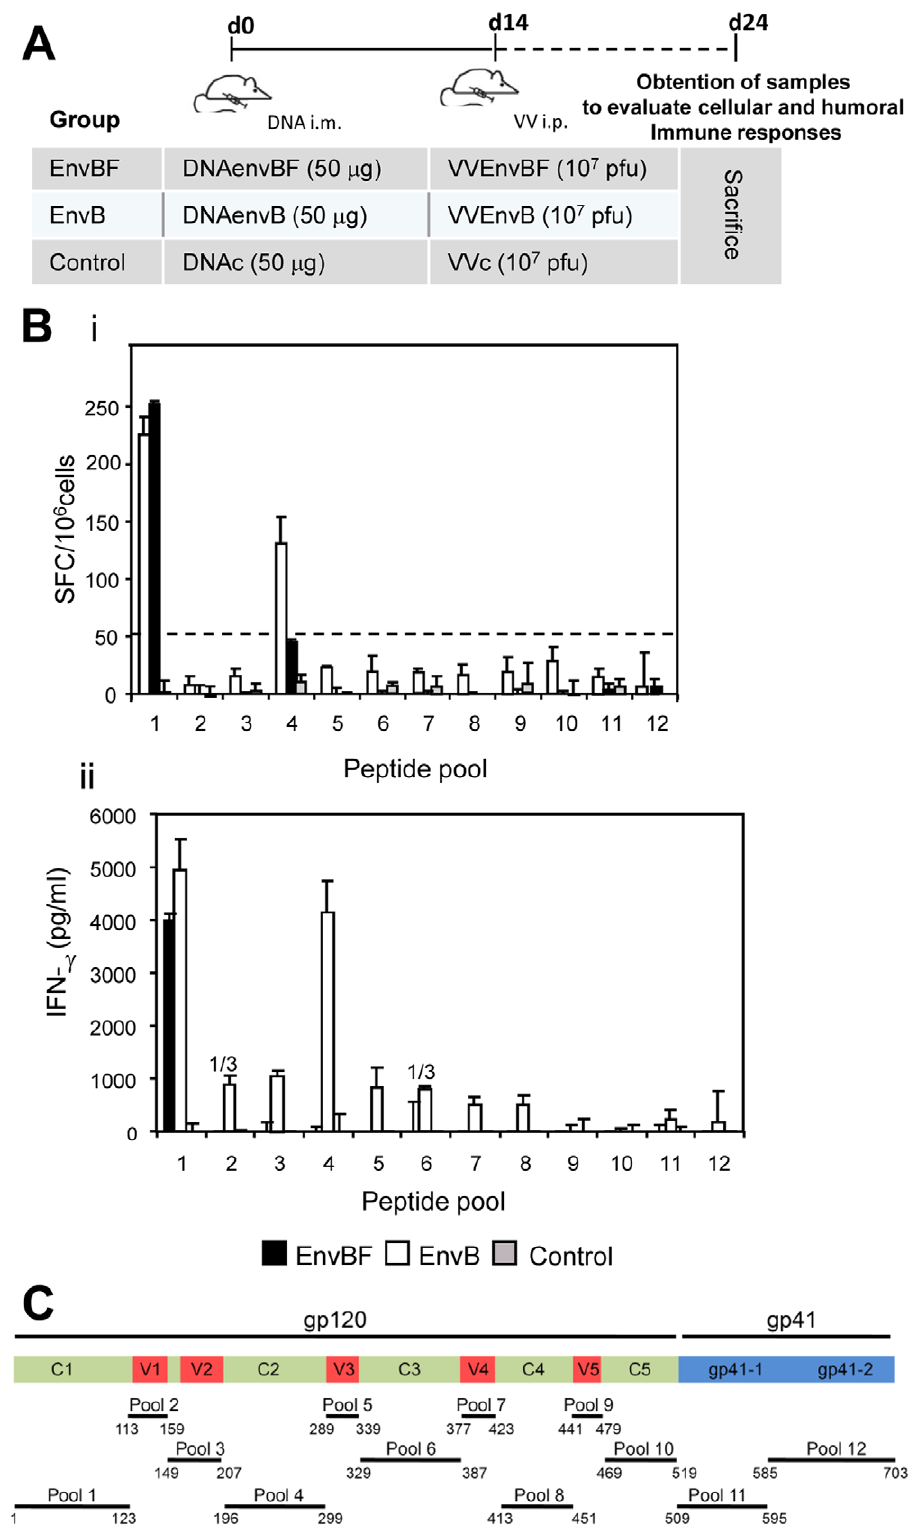
Figure 2. Immunogenicity of EnvBF vs EnvB proteins: cellular responses induced after DNAprime/VVboost vaccine regimes. A ) Description of the immunization scheme applied in groups of four Balb/c mice. B ) Ten days after the last immunization dose, cellular immune responses against EnvB were evaluated by ELISPOT (i) or ELISA (ii). To this, splenocytes from mice of the different groups were restimulated with the Env Con B peptide pools of indicated, during 24 hrs (i) or 72 hrs (ii). Bars represent the average net number of spots + / 2 SD for triplicate wells of pooled splenocytes (i), or IFN- c specific levels found in supernatants after substracting 2 6 value found in control unstimulated cultures (ii). C ) Scheme indicating the gp160 region included in the different peptide pools used, which were numbered from 1 to 12. Numbers upper the bars: 1/3 indicated that in one out of three experiments a positive value was obtained. Data are representative of three independent experiments.